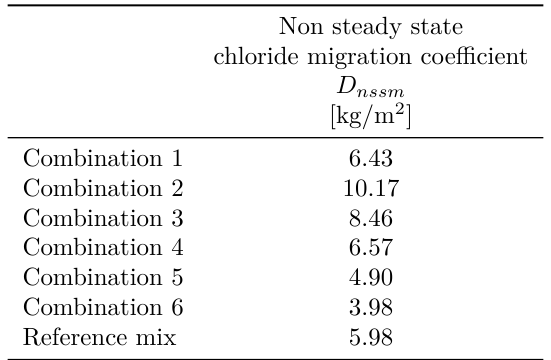
Table 7. Resistance to chloride migration of the concrete mixtures with maximum aggregate replace- ment. Table 8. Resistance to chloride migration of the